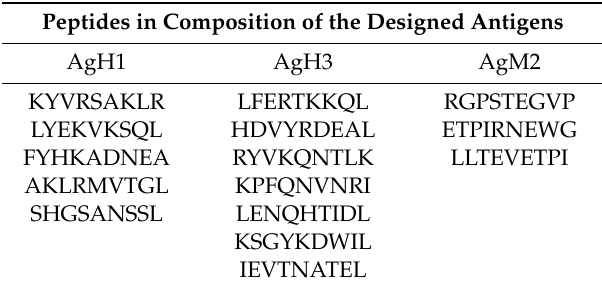
Table 2. Peptides selected for splenocytes stimulation in IFN- γ -ELISpot assays. Peptides in Composition of the Designed